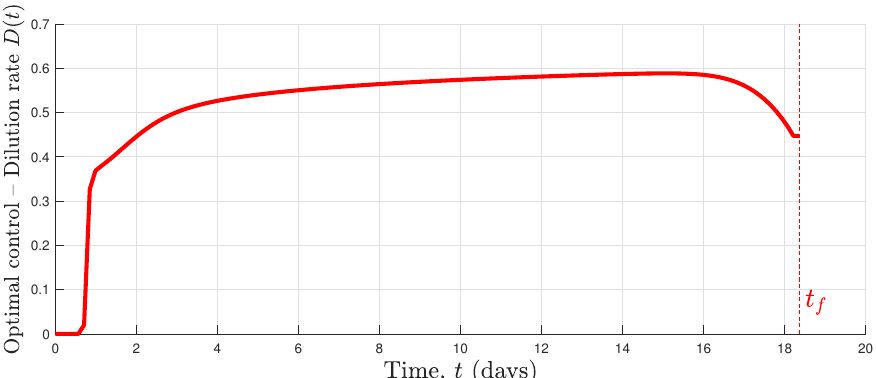
Figure 4. The optimal control in Example 2 ( s 0 = 4, q 0